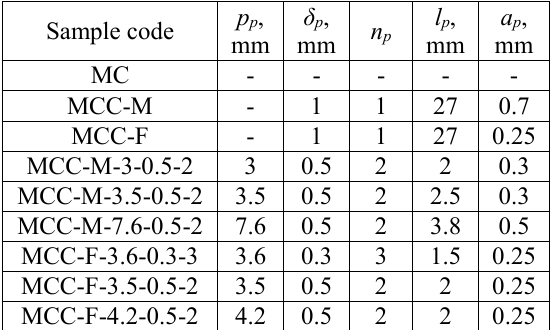
Table 1. Specimen code and specification.